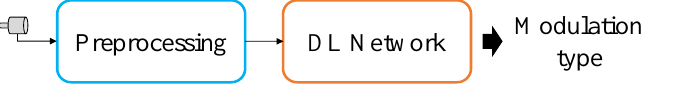
Figure 1. Basic flow of a single hydrophone modulation recognition method based on DL.